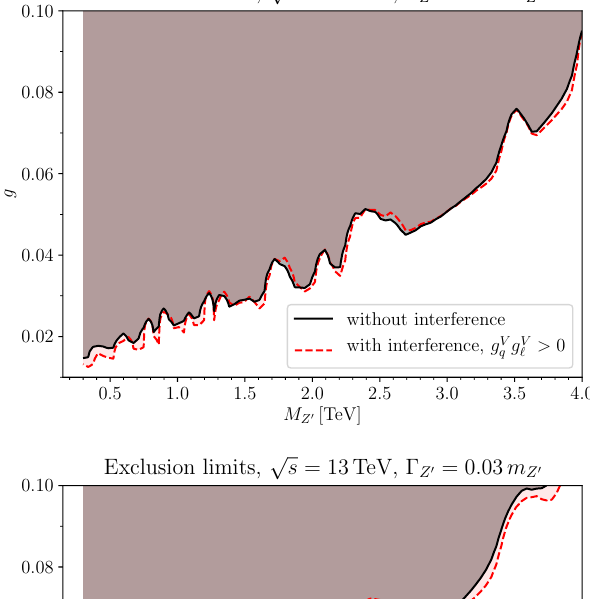
g V ) 1 = 2 at 95 % con(cid:12)dence level, with and q ‘